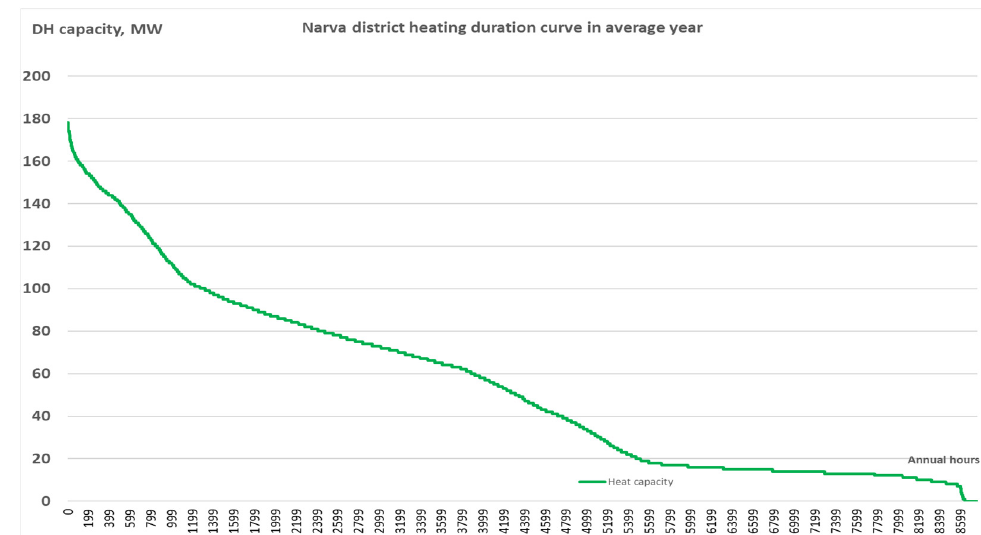
Figure 7. Narva district heating average annual duration curves.